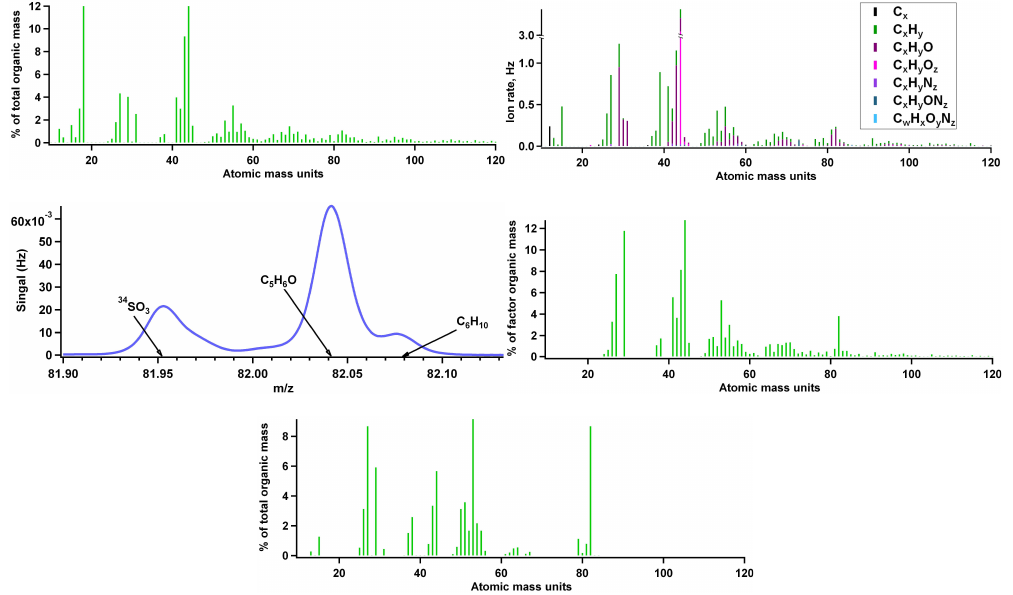
Fig. 2. Various AMS mass spectra showing a MF peak at m/z 82, including (a) a C-AMS mass spectrum measured aboard the FAAM aircraft during a period of high m/z 82 signal, (b) a high resolution mass spectrum measured from the ground site during a period of high MF signal, (c) detail of the m/z 82 peaks during the same period of high MF signal, (d) the 82Fac organic aerosol factor from PMF analysis of the ground site mass spectra and (e) a mass spectrum of 3MF suspended in water and measured in the laboratory.